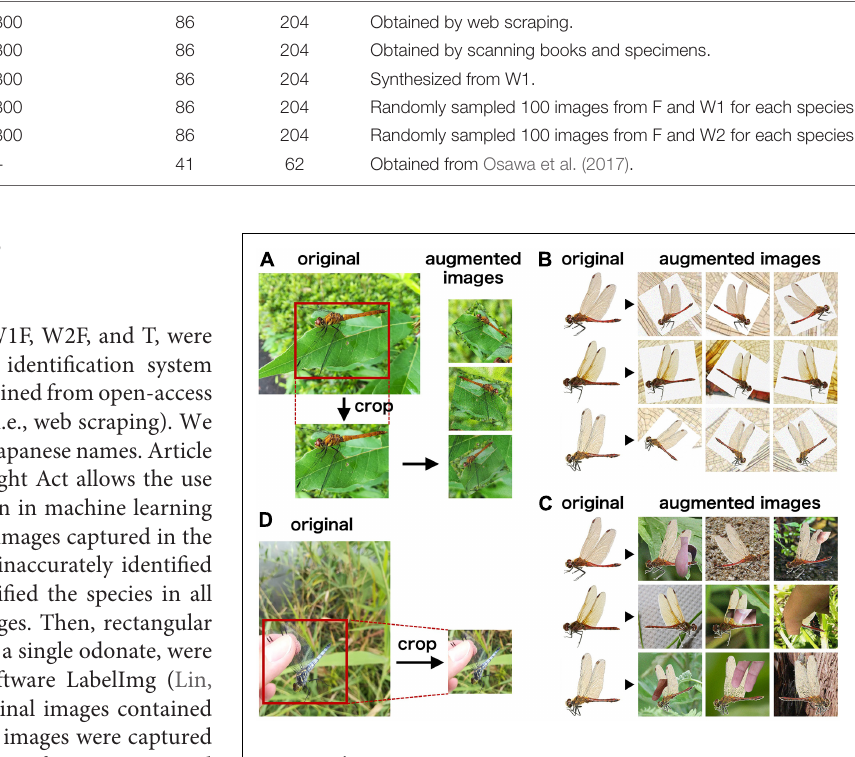
FIGURE 1 | Examples of the images for model training and validation. (A–C) Examples of the original images and augmented images in dataset F (A) , W1 (B) , and W2 (C) . (D) Examples of the original images from citizen surveys and the cropped images for model validation.